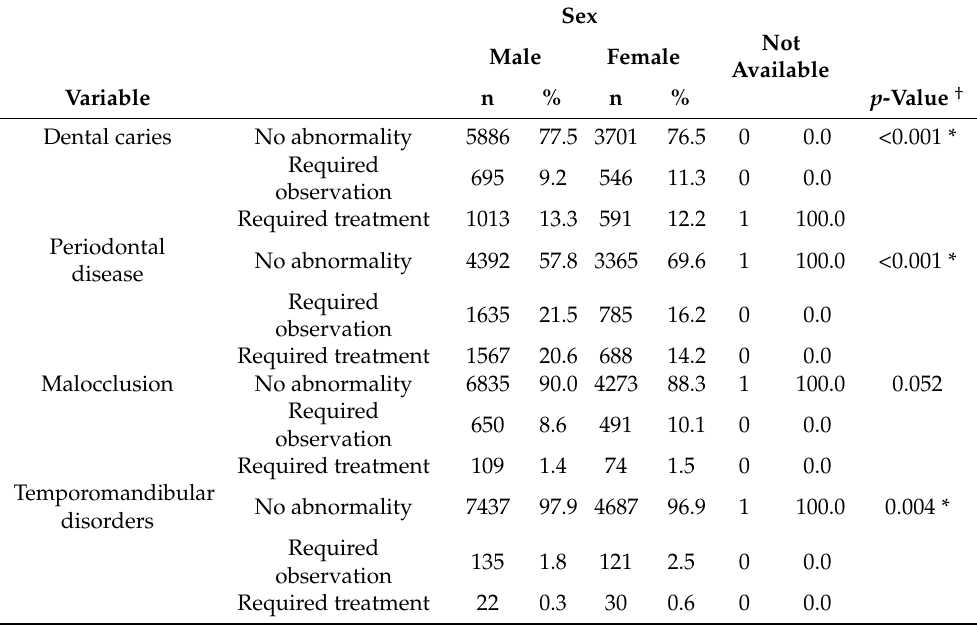
Table 2. Participants’ characteristics of dental health status stratified according to